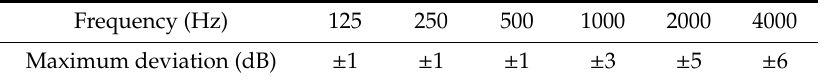
Table 1. The maximum deviation of directivity of source in decibels for excitation with octave bands of pink noise and measured in free field (ISO 3382-1).